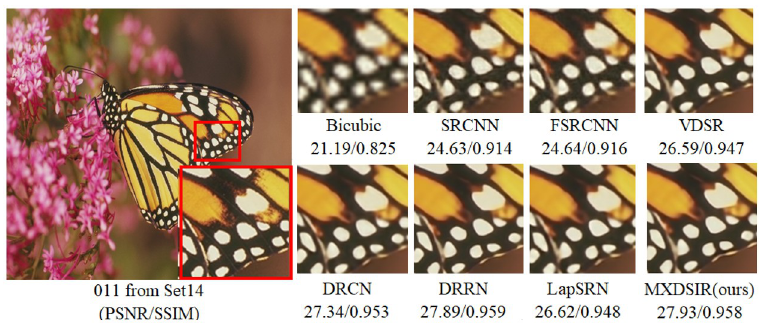
Fig 8. Visual performance of images with 8 × enlargement factor of image 011 from Set14 dataset.